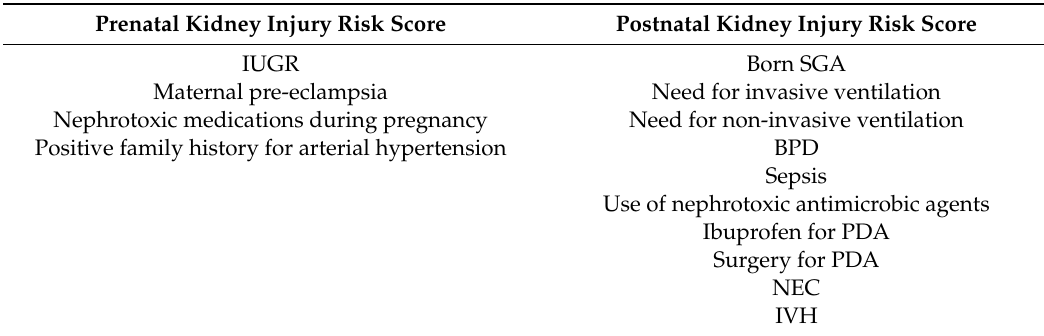
Table 1. Items considered in prenatal (range 0–4 points) and postnatal (range 0–10 points) kidney injury risk scores (each ‘Yes’ answer accounts for 1 point). Prenatal Kidney Injury Risk Score Postnatal Kidney Injury Risk Score IUGR Born SGA Maternal